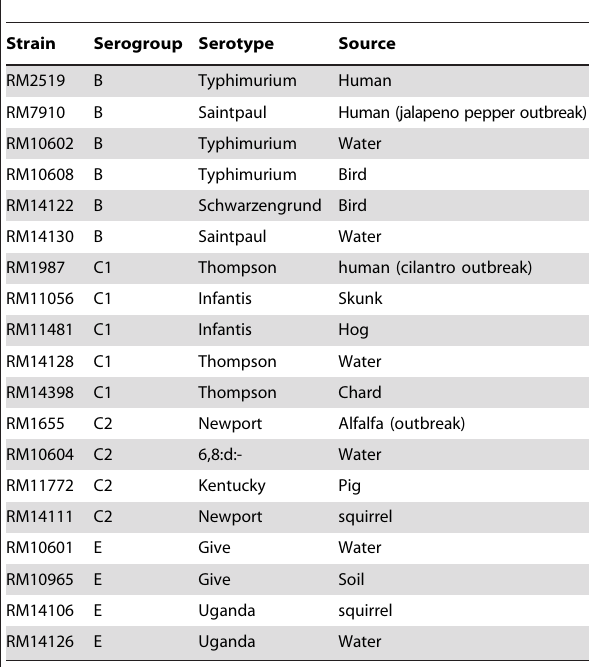
Table 1. Strains used in this